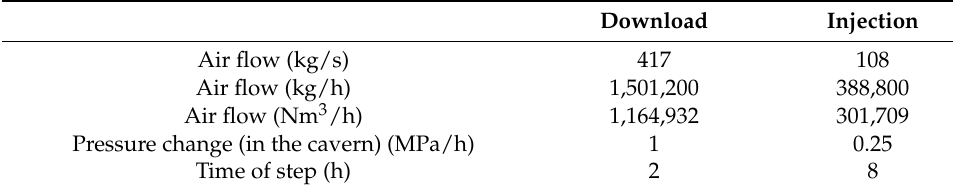
Table 4. Air flow during download/injection.